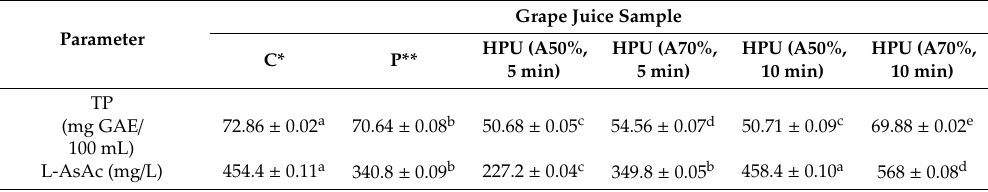
Table 2. E ff ect of pasteurization and HPU treatments on the total phenolic (TP) and l -ascorbic acid (L-AsAc)